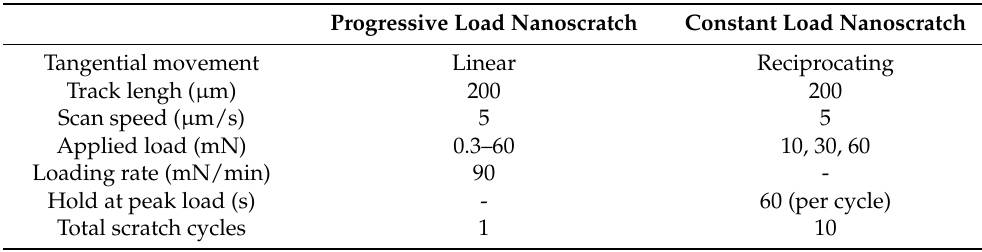
Table 1. Experimental parameters in the nanoscratch tests using the 2 µ m